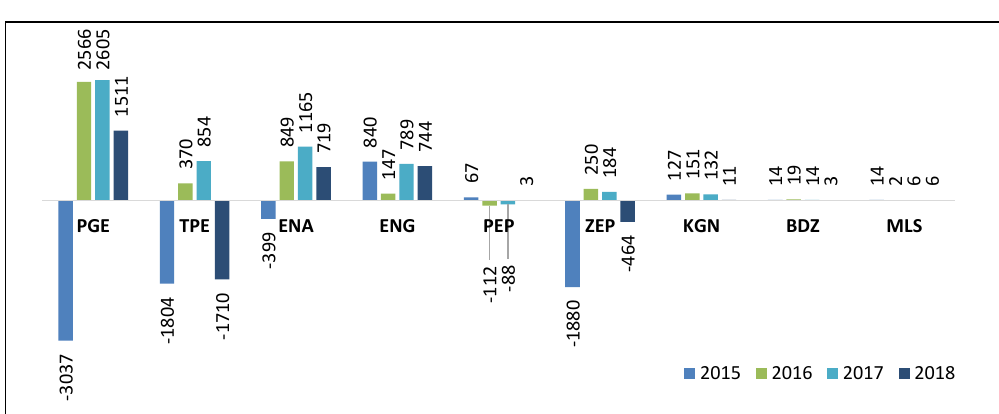
Figure 5. Sampled companies according to net profit (in mln of PLN). Table 3. Profitability ratios of the examined companies.